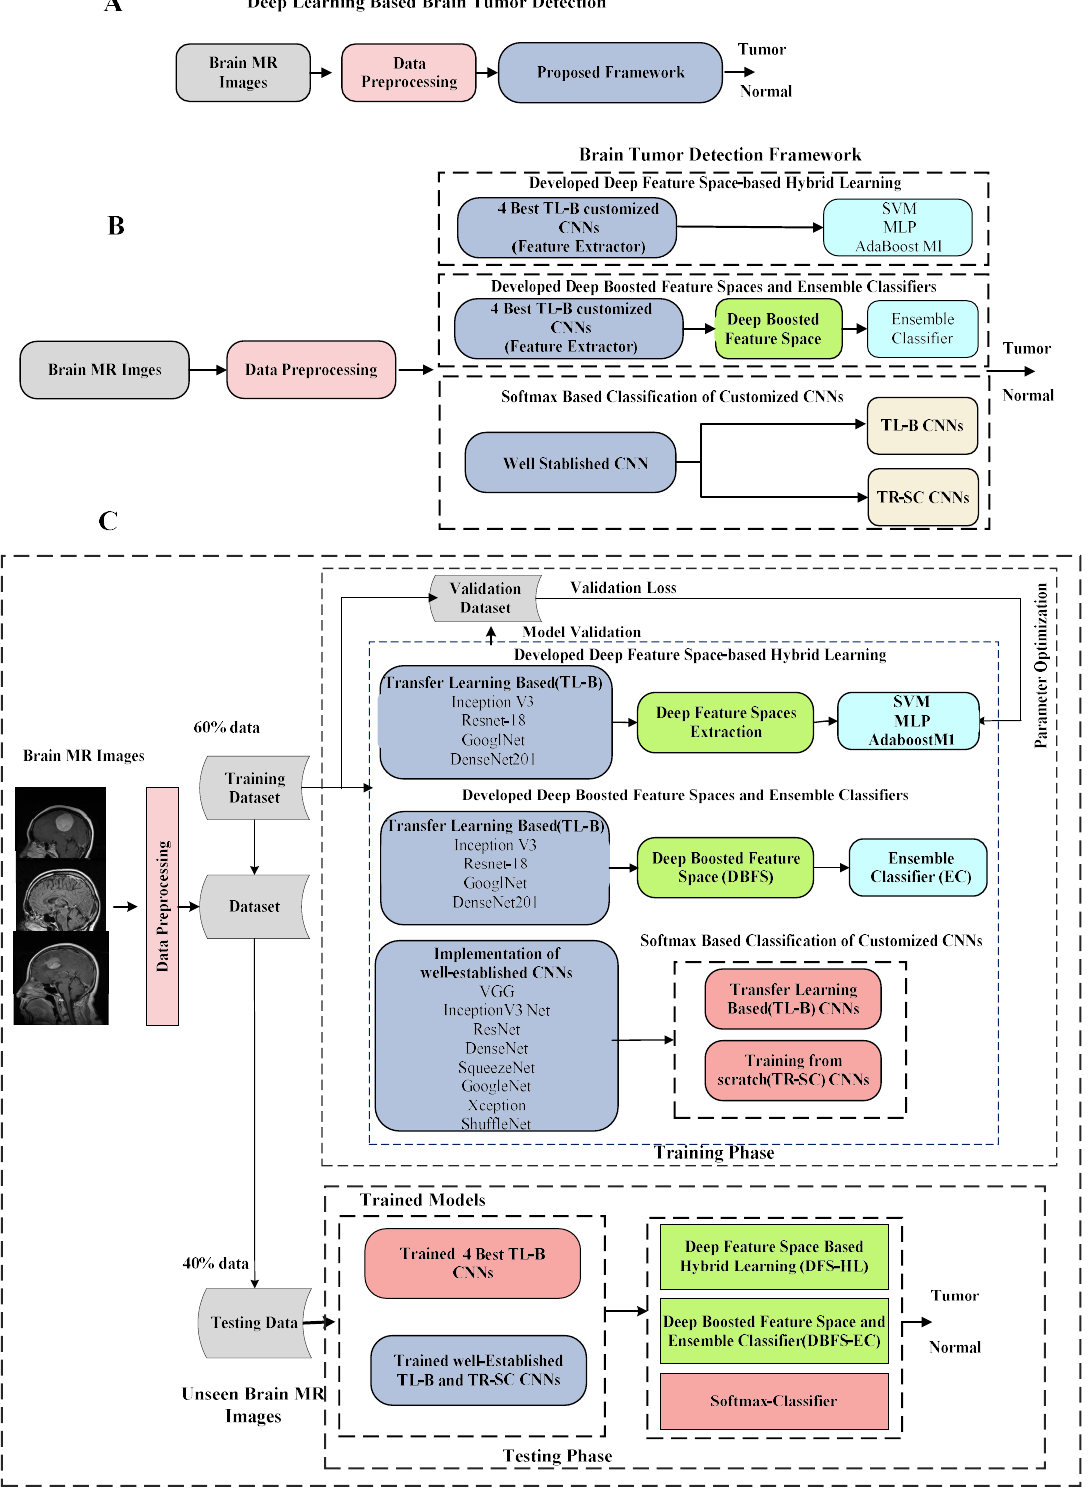
Figure 2. Overall detailed description of the proposed brain tumor analysis framework. ( A ) Block flow diagram. ( B ) Overall workflow overview. ( C ) Detailed block diagram of proposed deep learning-based brain tumor detection scheme.